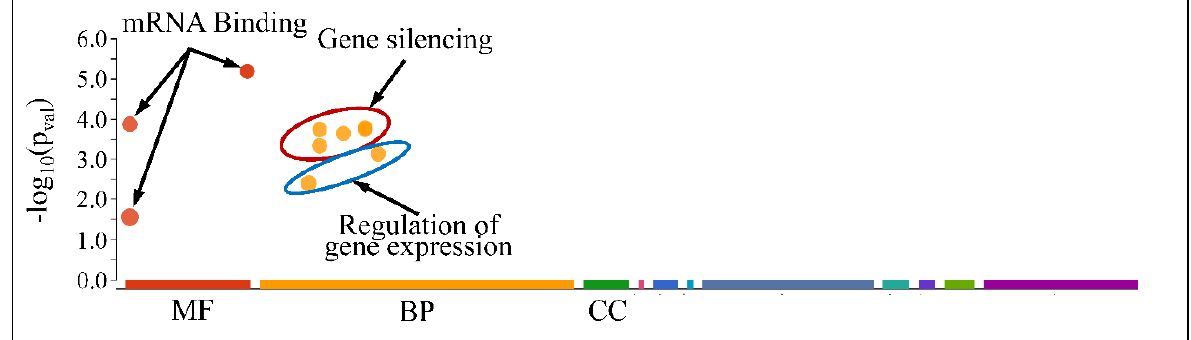
Figure 12. Functional annotation (GO enrichment analysis) of miRNAs found to be globally deregulated across all CNS tumor samples (Legend: MF: Molecular Function, BP: Biological Process, CC: Cellular Component).